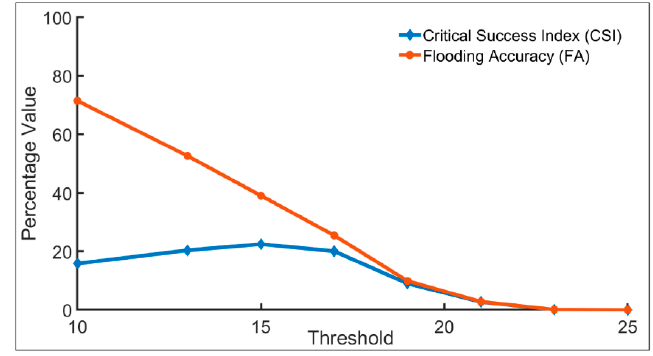
Figure 6. Mapping critical success index (CSI) and flood accuracy (FA) of proposed model output, compared with the Sentinel-derived flood inundation map for the Kerala flood event of August 2018.